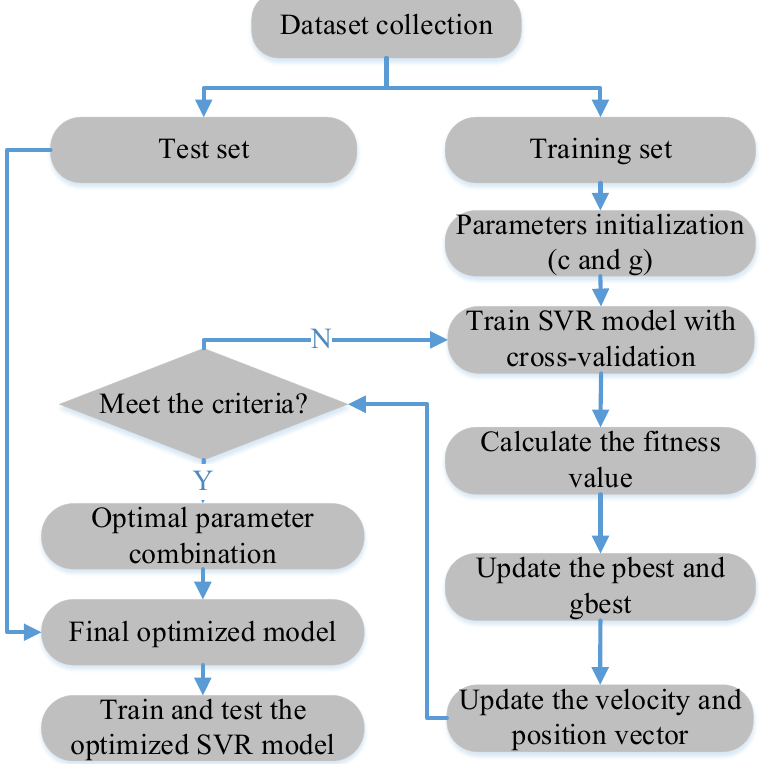
Figure 3. Flowchart of the proposed hybrid model.